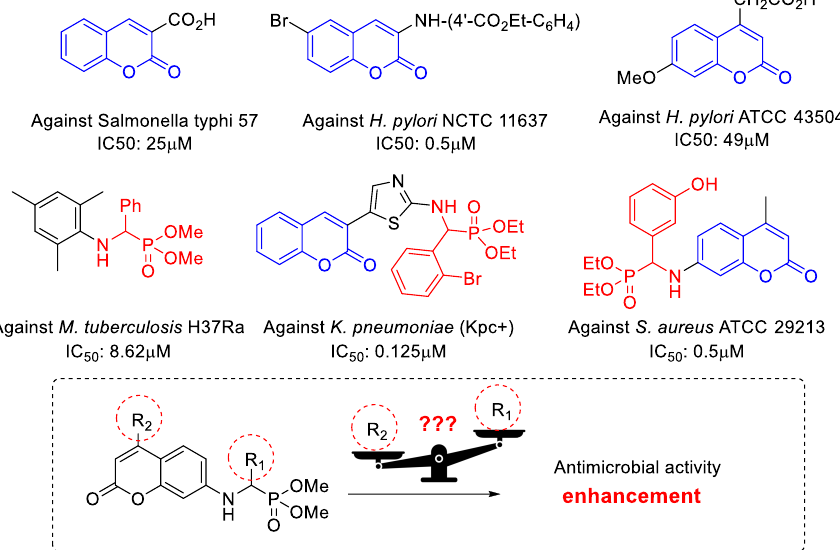
Figure 1. Biologically active antimicrobial coumarin and α -aminophosphonate derivatives.